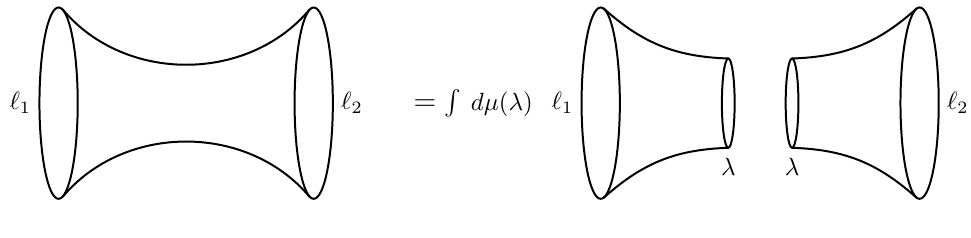
Figure 9 . We depict the cylinder amplitude in physical space between fixed length boundaries. The final answer can be interpreted as gluing minimal string trumpets generalizing the procedure of JT